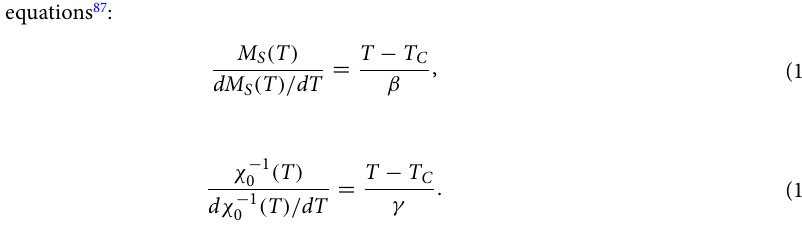
MAPs for our sample around T C 1 , the value of β and γ are 0.152 and 0.750 respectively. Using Widom scaling law γ/β + 1 = δ , the value of δ is found to be 5.930.